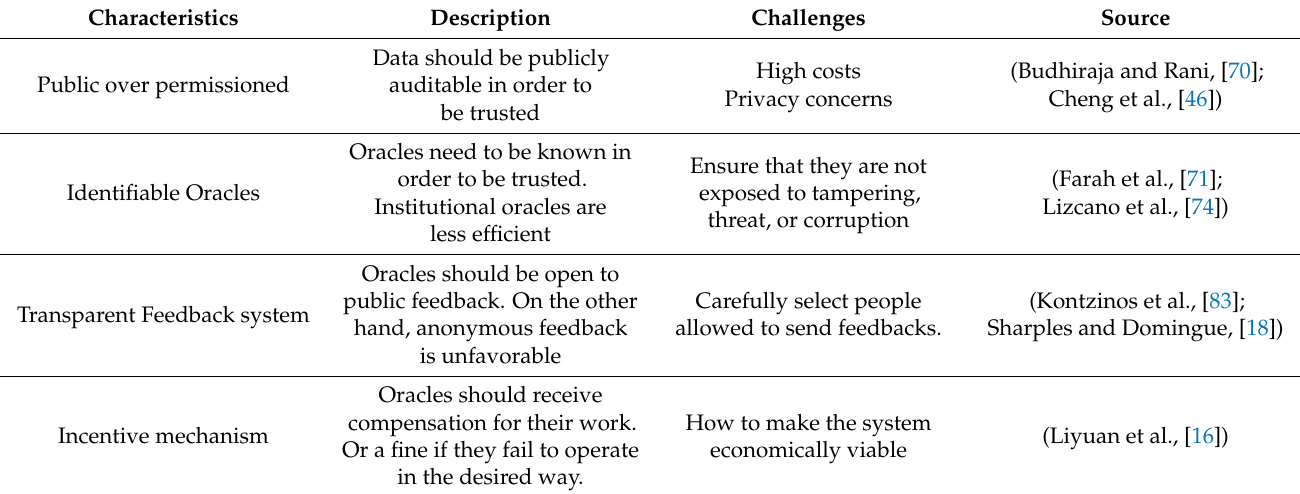
Table 5. Features to address the oracle problem in academic blockchain